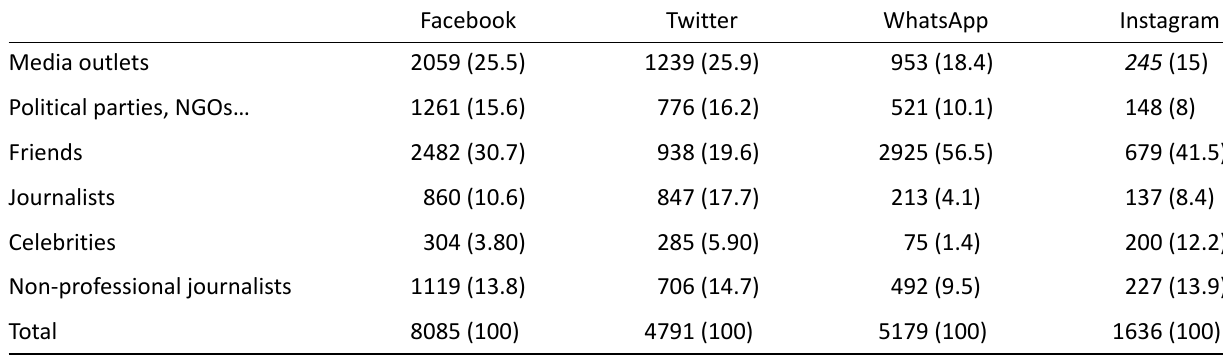
Table 3. Social networks used for getting/sharing/commenting news by